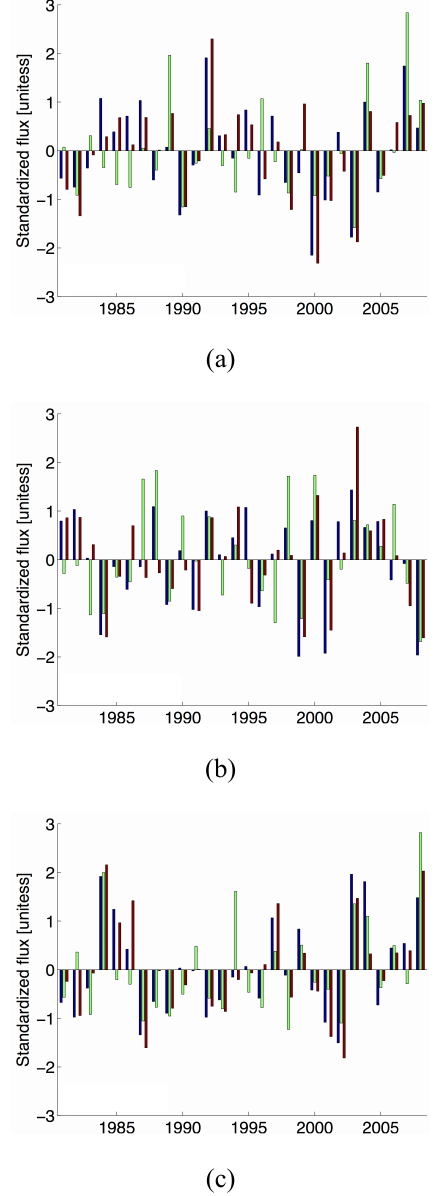
Figure 10. Same as Fig. 9 but for Summit